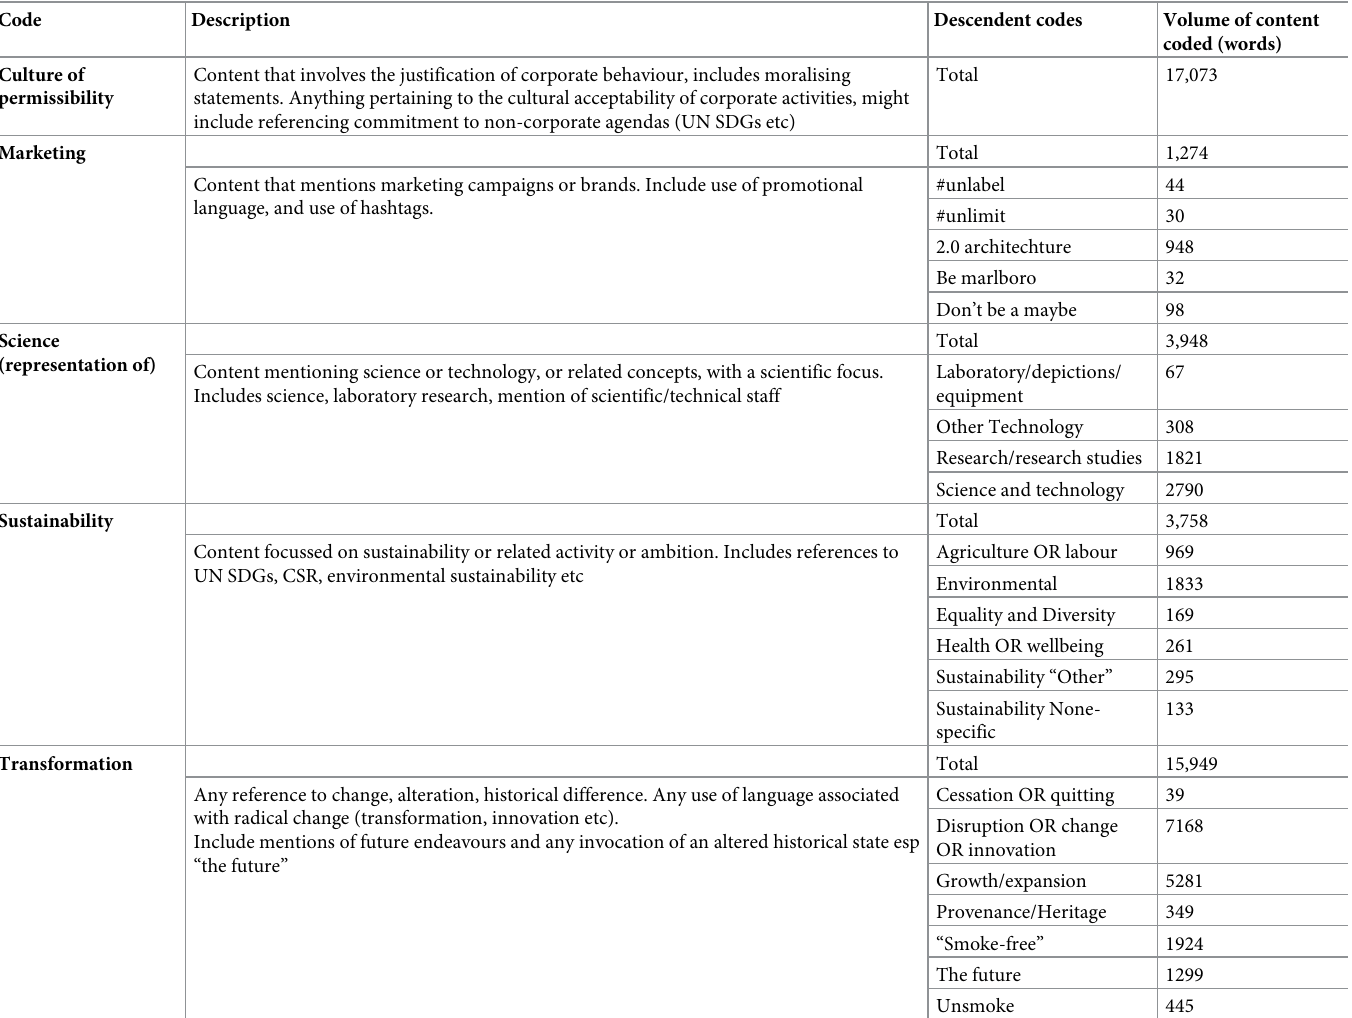
Table 4. Volume of content coded to top 2 levels of the